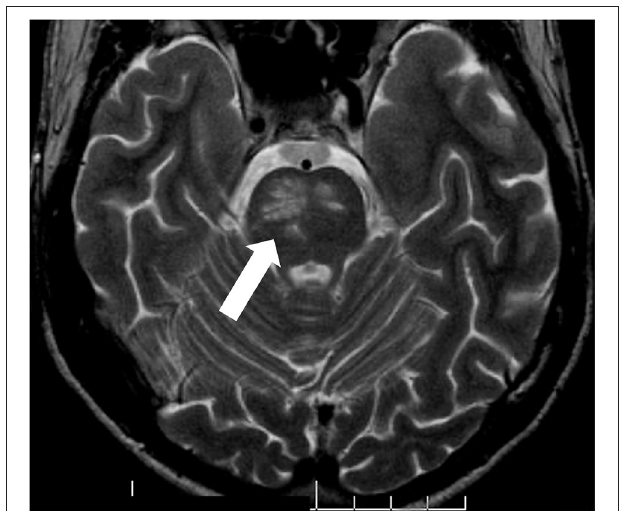
FIGURE 2 | pNBS with a vasulitic lesion in the brainstem (MRI FLAIR sequence). Twenty eight years old male patient with aphasia, hemiparesis, who had definite BS according to the international study group criteria since the age of 21.